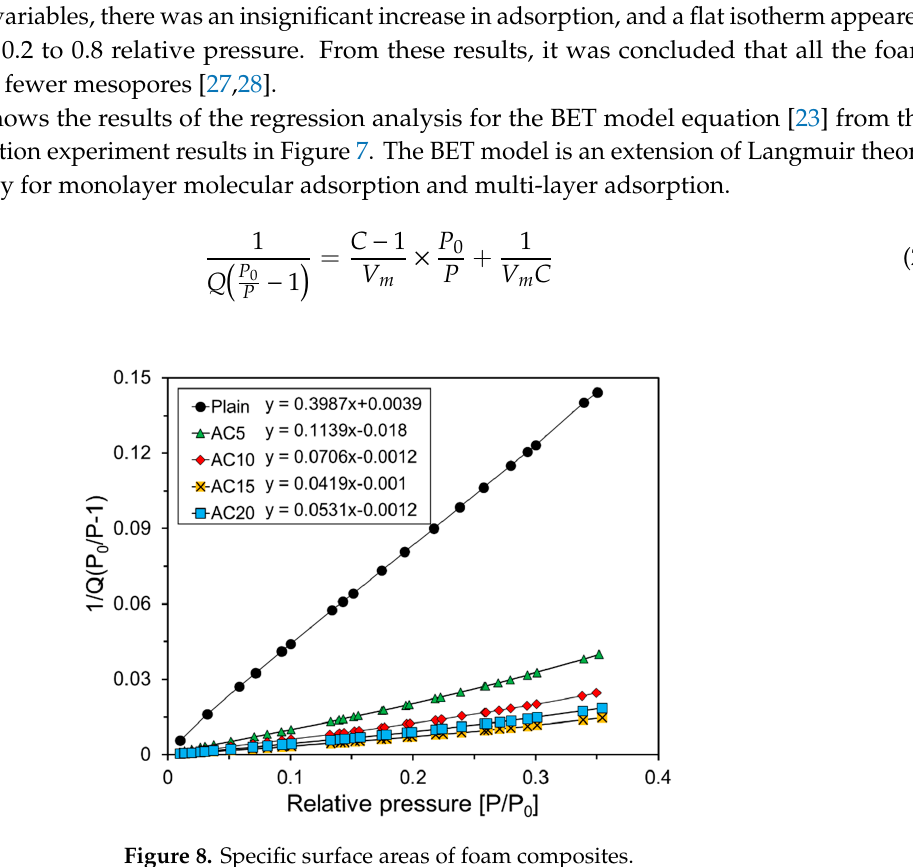
Figure 7. Nitrogen adsorption isotherm curves of foam composites.